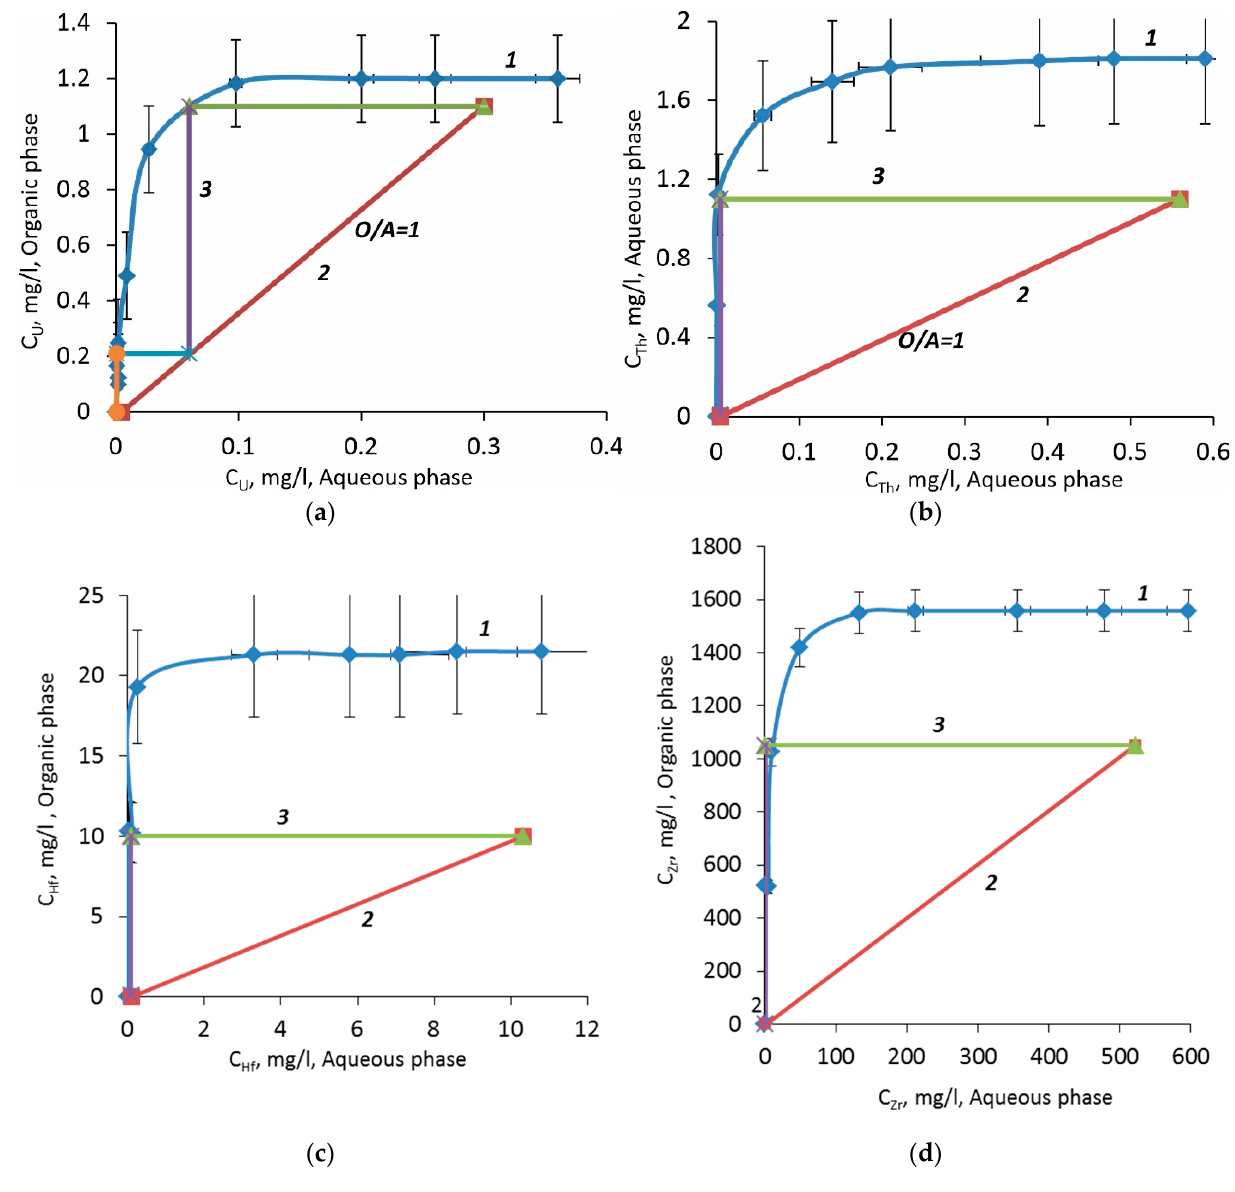
Figure 7. Extraction isotherm of U(VI) ( a ), Th(IV) ( b ), Hf(IV) ( c ), and Zr(IV) ( d ) from the eudialyte breakdown solution (2.84 M HNO 3 ) by a (R 4 N) 2 L ionic pair solution in 1,2-dichloroethane (0.05 M by H 2 L) at 20 °C (1), working line (2), and extraction stage (3). For the calculation of the error bars, random and non-excluded, as well as the device error for determination of the concentration of metal ions, were taken into account. The study was carried out using at least three independent experiments. The total error of the results was ~18.4%, taking into account the non-excluded and random components.